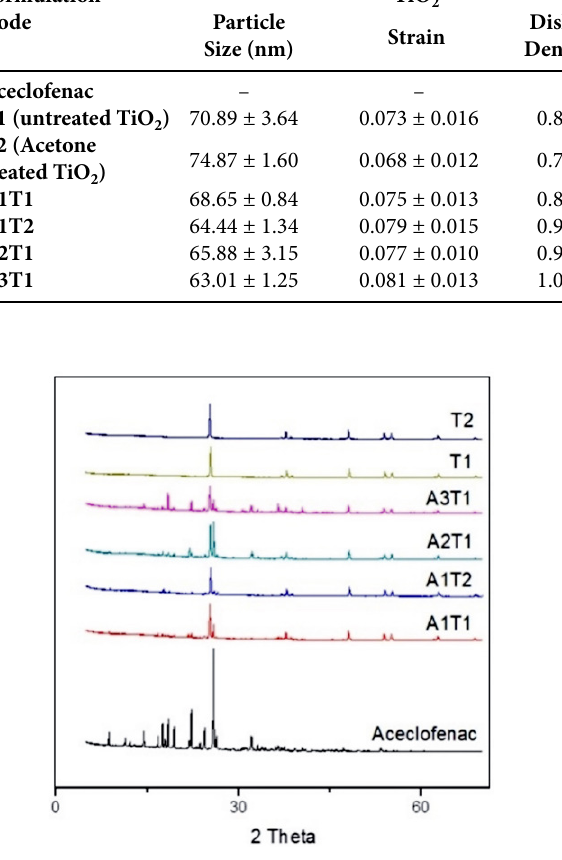
Figure 3. Powder Xray diffraction overlay of pure drug, formulation, untreated and treated titanium dioxide (T1 and T2 respectively).